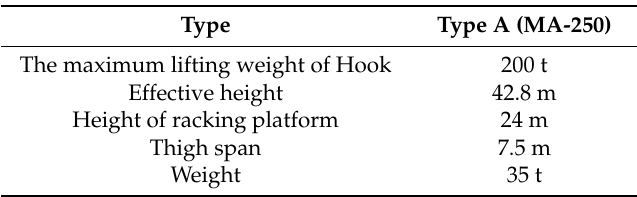
Table 3. Maximum wind speed of derrick in different working states.